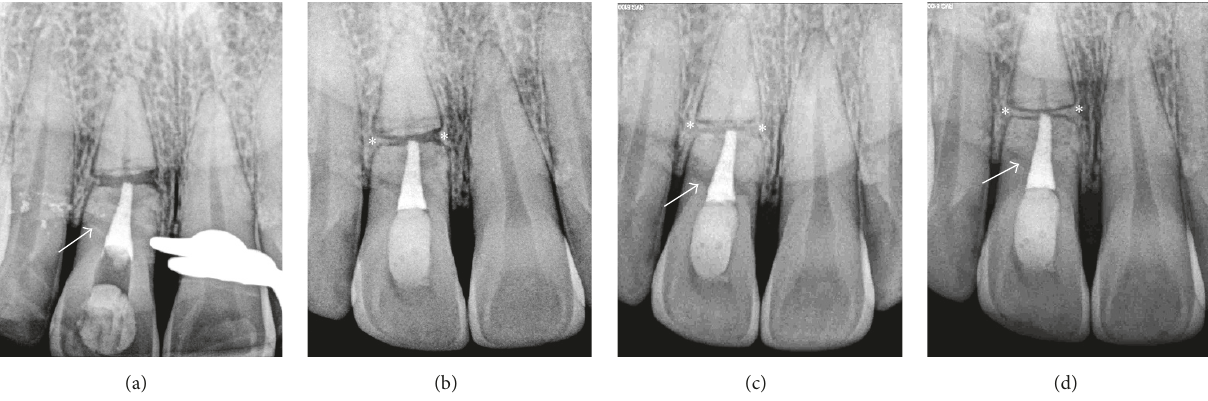
Figure 2: Digital periapical radiographs. (a) Radiograph immediately after MTA obturation in coronal root fragment (June 2013) illustrates approximately 0.5 mm extruded MTA at the apical end of the coronal fragment and a suspected fracture line at the level of the cervical third on the distal aspect of the root (arrow). (b) Radiograph one year after MTA obturation (June 2014) reveals the ingression of bone into the diastasis from both mesial and distal aspects of the fracture, but it does not fill the central aspect of the diastasis (asterisks). The apical root fragment has a continuous lamina dura without apical radiolucency. ((c) and (d)) Radiographs two years after MTA obturation (June 2015) show complete healing at the diastasis (asterisks). A radiolucent line at the distal aspect of the cervical third of the root is still noticed (arrows).